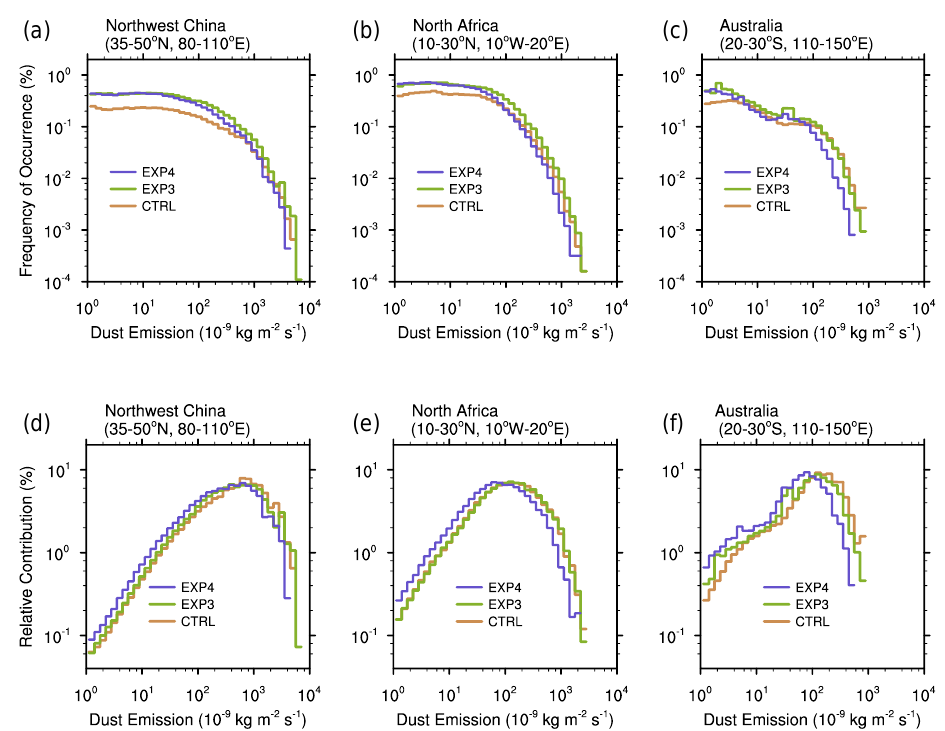
Figure 19. Upper row: frequency distribution of simulated dust emissions in (a) Northwest China, (b) North Africa, and (c) Australia. Lower row: relative contribution of each emission flux bin to the total emission in those three regions. The results were derived from hourly emission fluxes of the year 2006. All grid cells in each region were treated as individual samples.